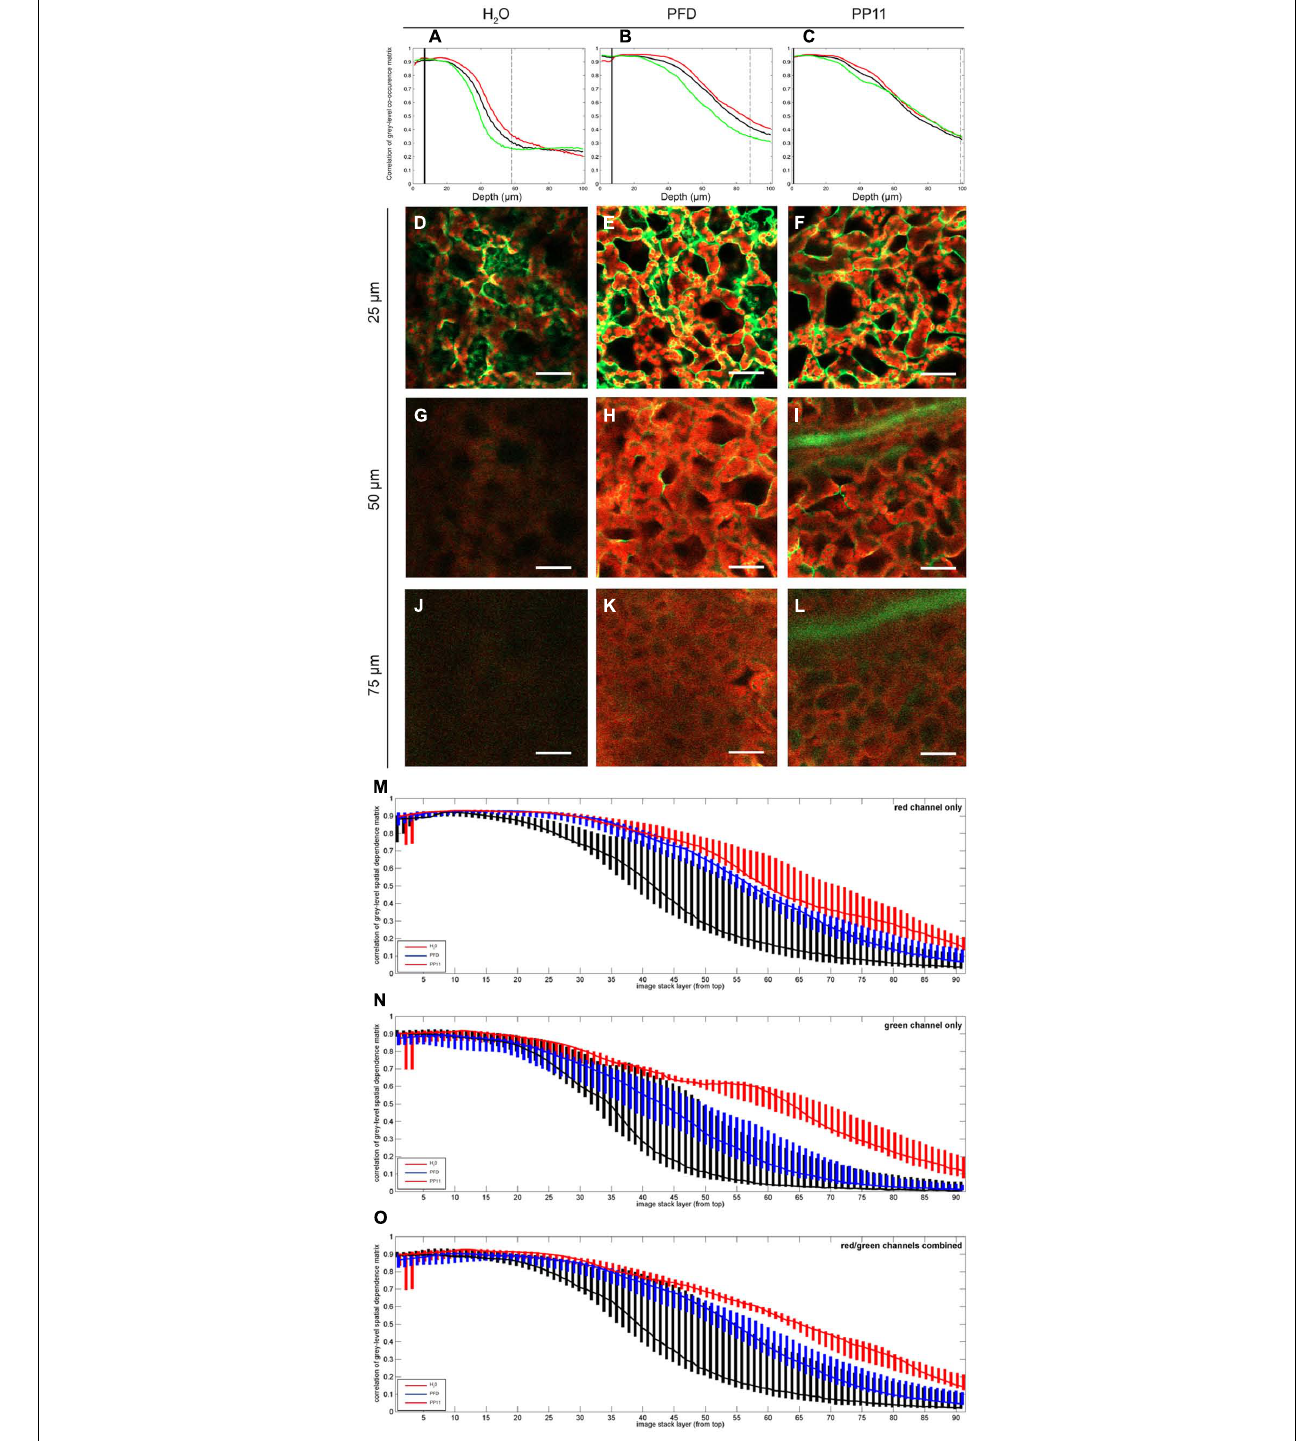
respectively. Signal was collected from 518 to 604 nm for Venus, and is displayed in green and at 647–690 nm for chlorophyll, shown in red. (J–L) representative images taken at a depth of 75 μ m from samples mounted in H 2 O, PFD, and PP11 respectively. (M–O) range and median plotted for all samples ( n = 5) mounted in H 2 O, PFD, or PP11 for red, green, and total signal respectively. Scale bars are 50 μ